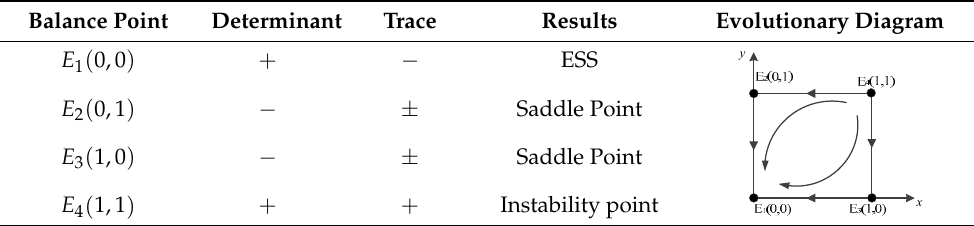
Table 5. Scenario 2 evolutionary game model steady state